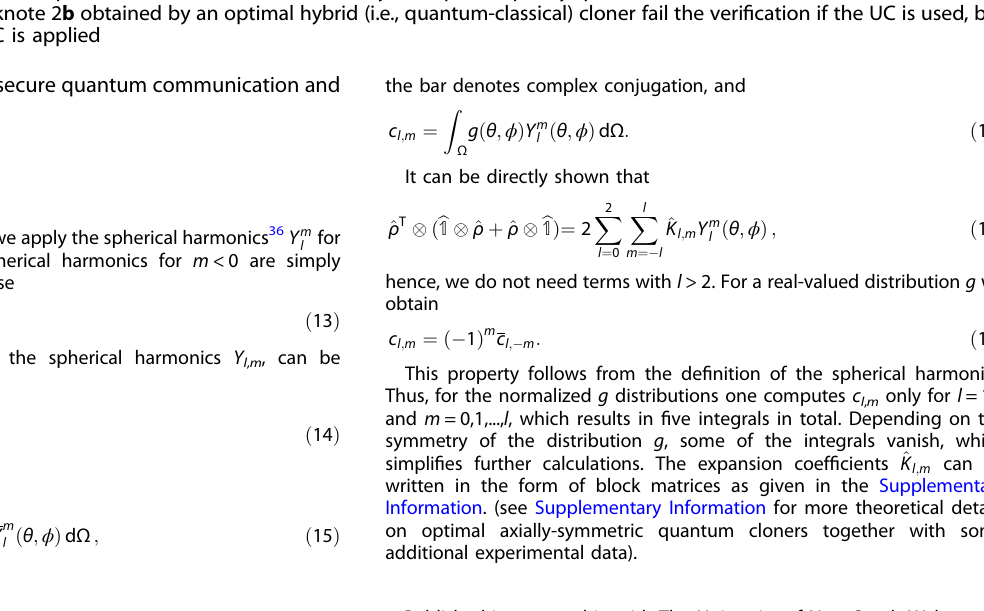
Fig. 4 Experimental quantum banknotes 1 a and 2 b are copied probabilistically with an optimal 1-to-2 linear optical cloning machine shown in Fig. 3 and subsequently veri fi ed. This device can be tuned to implement, in special cases, the UC, the PCC, and the MPCC. Note that the white regions in quantum banknotes, or their copies, correspond to either a lack of photons or the cases where the cloning process failed to deliver one photon per banknote. One observes that the copies, which are provided with the best possible cloning machines, are noisy and, thus, the sequences of qubits are damaged (shown in red). The performance of a given cloning process depends on the statistics of photon polarizations. Thus, the copies of quantum banknote 1 a obtained by an optimal purely-quantum cloner (the UC and MPCC) fail